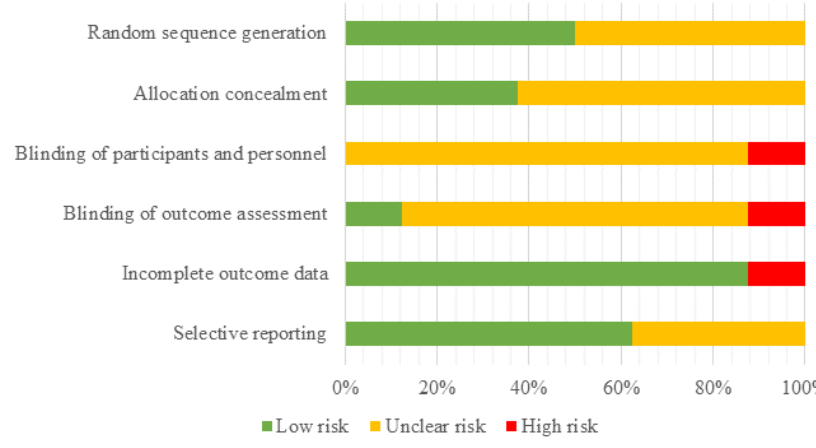
Figure 2. Risk of bias assessment